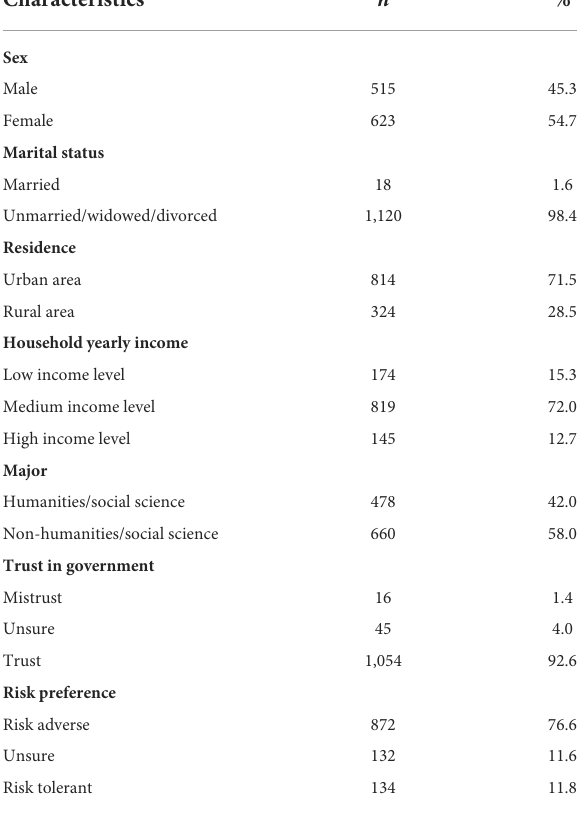
TABLE 3 Characteristics of the student sample ( n =